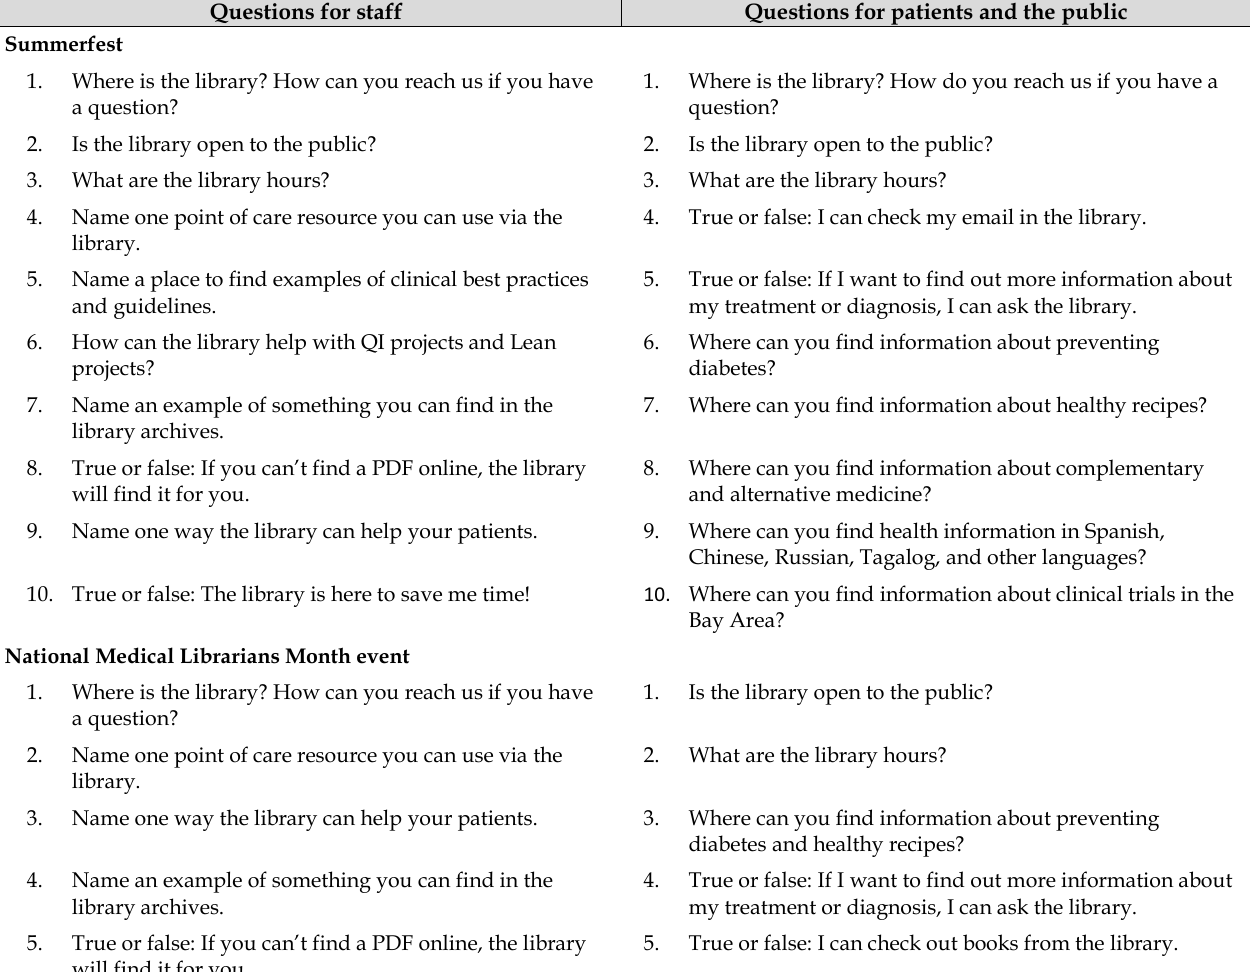
Table 1 List of questions used in the raffle activity for Summerfest and National Medical Librarians Month events Questions for staff Questions for patients and the